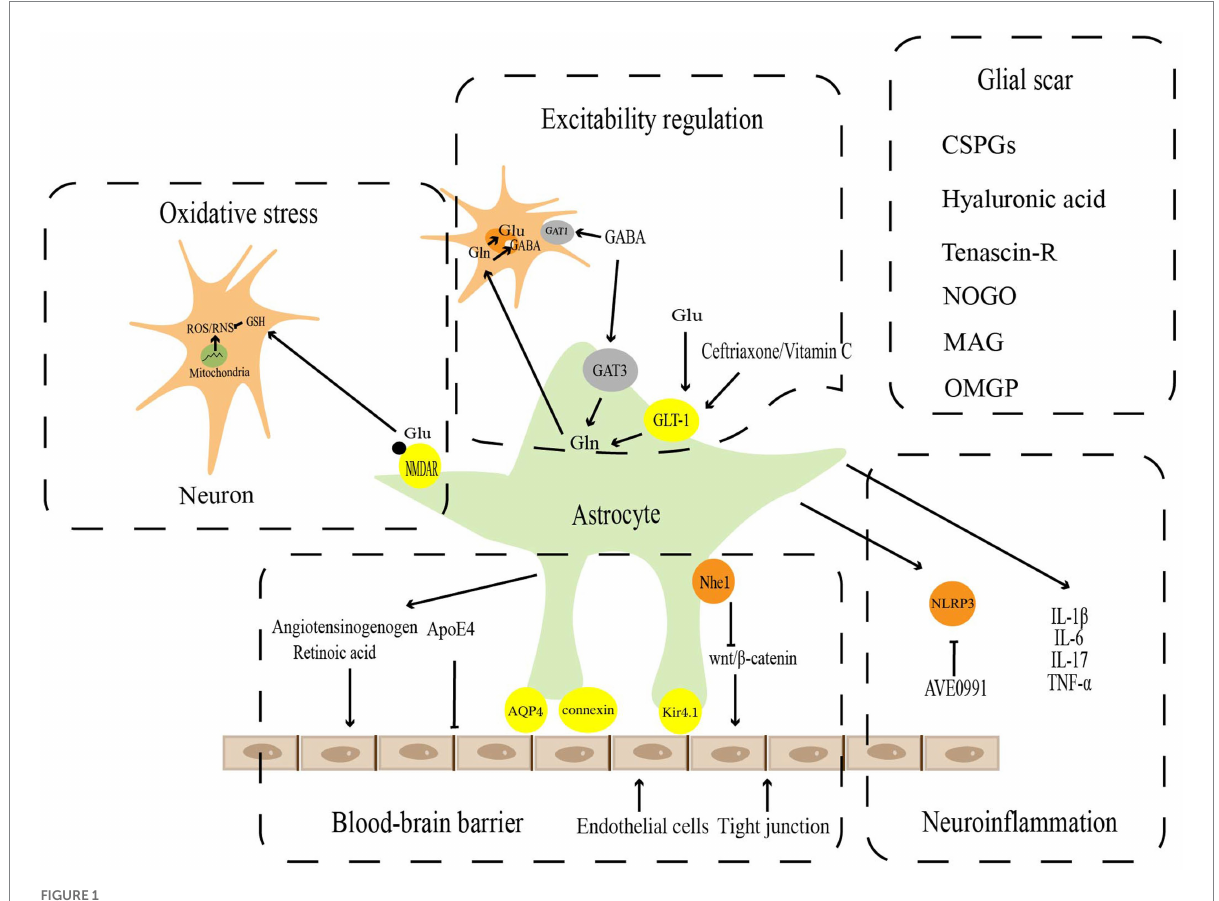
FIGURE 1 Pathophysiological functions of reactive astrocytes. Astrocytes play a key role in the maintenance of CNS homeostasis, including blood–brain barrier, excitatory regulation, oxidative stress, neuroinflammation, and Glia